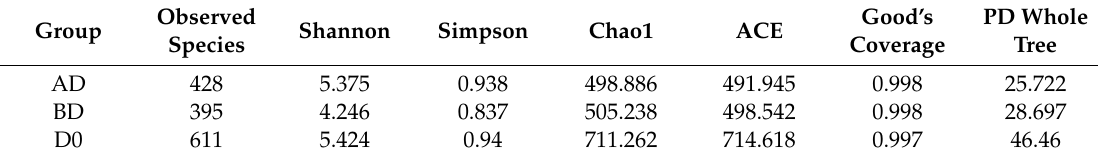
Table 2. The alpha diversity index (all groups).